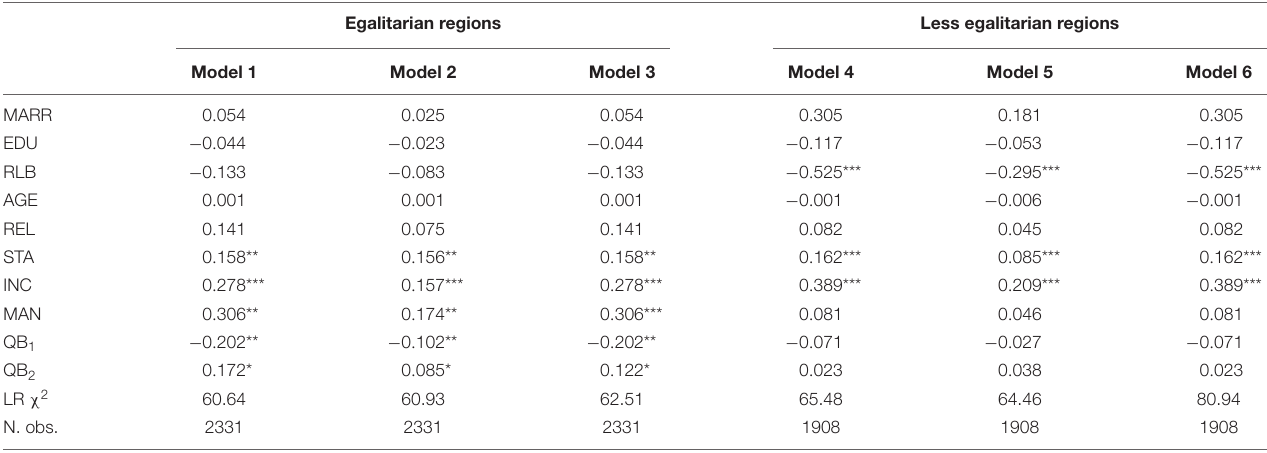
TABLE 7 | Determinants of happiness (egalitarian regions and less egalitarian